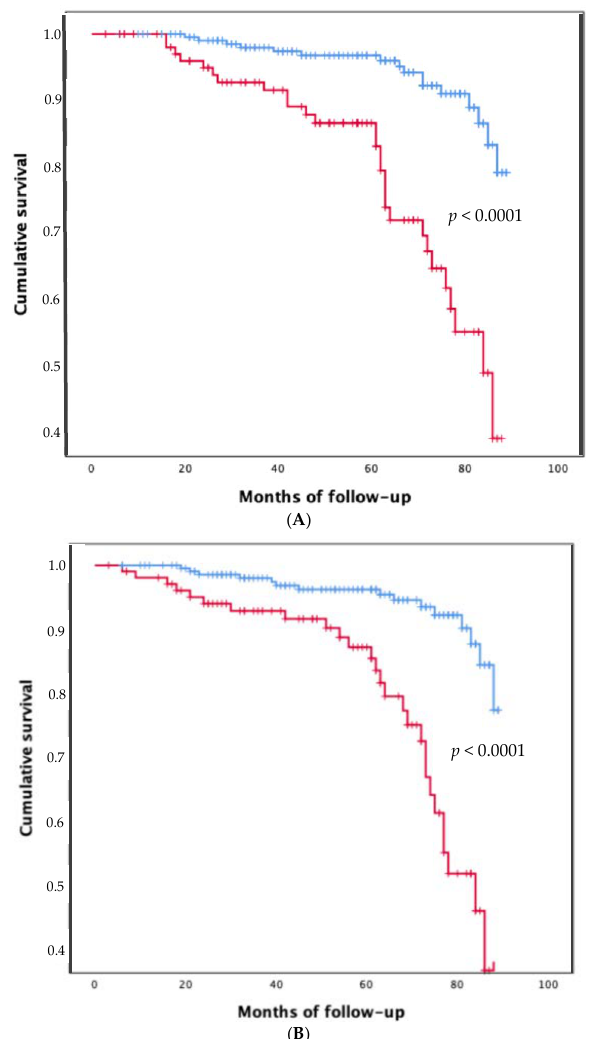
Figure 3. Incidence of liver decompensation events ( A ) and HCC development ( B ) in patients with gamma globulin <1.8 gr/dl (blue line) and ≥ 1.8 gr/dl (red line).